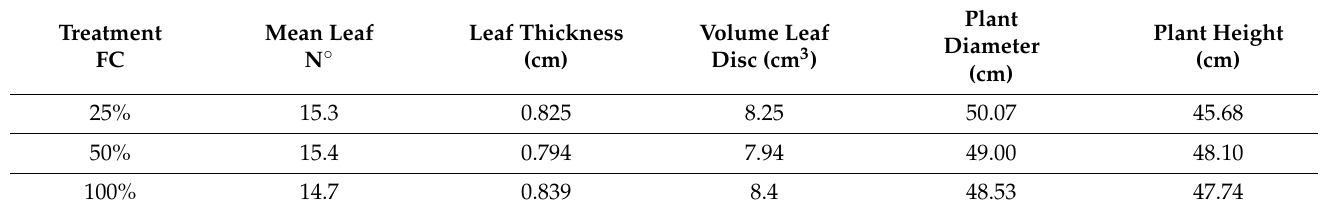
Table 1. Growth parameters in Aloe plants after three months of preconditioning. Treatments showed no evidence of significant differences ( p >